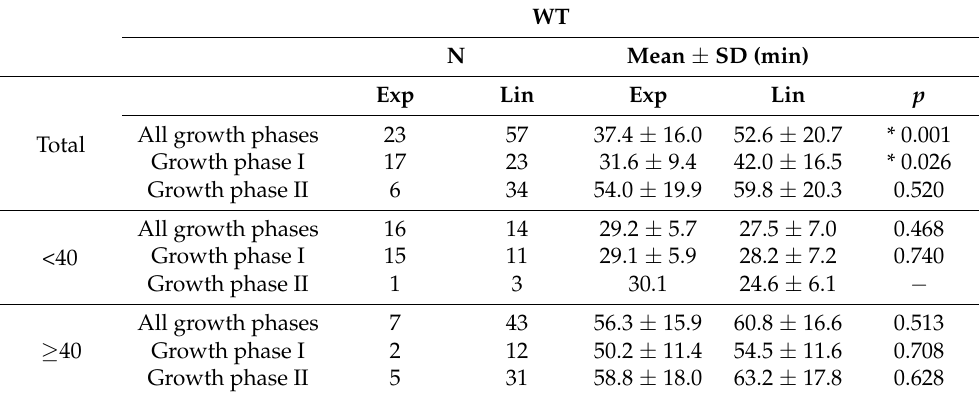
Table 2. Results of the two-sample t -tests for analysing the growing phases in those wild-type cells, which grew biline- arly.